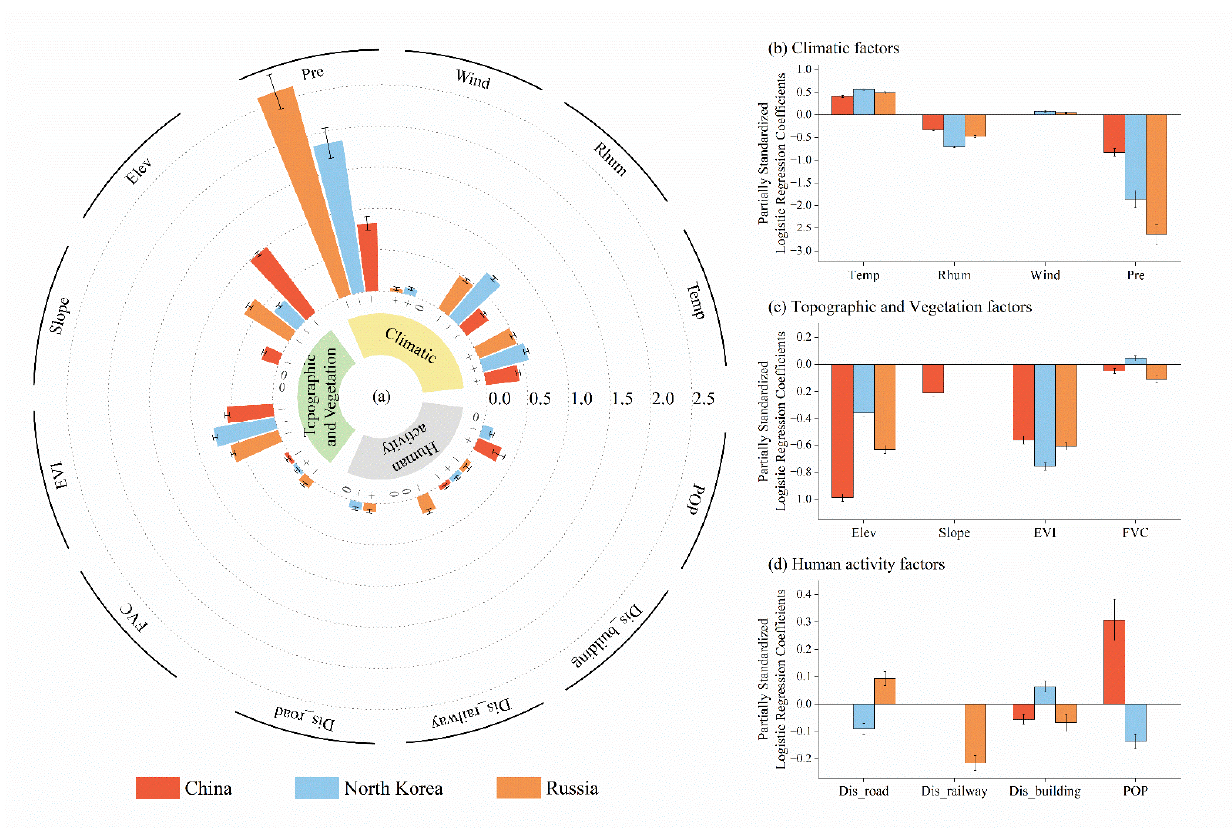
Figure 3. Comparison of the relative importance of forest fire occurrence drivers in different coun- tries. ( a ) Comparison of partially standardized logistic regression coefficients for all drivers. The outermost arcs show different variable names, with “+” at the bottom of each column meaning that the coefficient was positive, “−” meaning that the coefficient was negative and “0” meaning that the coefficient did not pass the significance test in the previous stepwise regression. ( b ) Comparison of partially standardized logistic regression coefficient of climatic factors, ( c ) topographic and vegeta- tion factors, and ( d ) human activity factors.